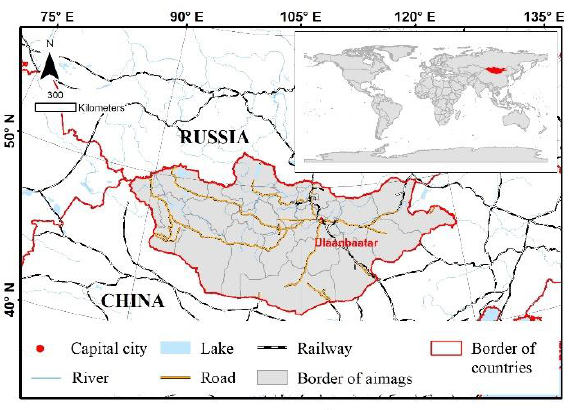
Figure 1. Location of study